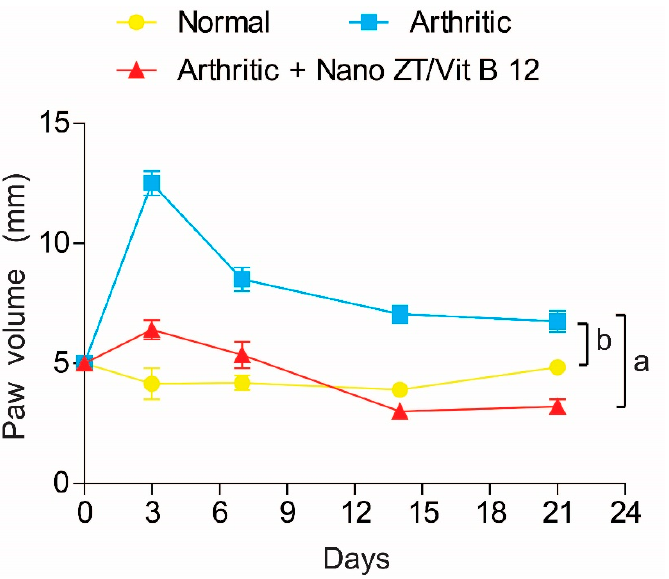
Figure 8. Effect of Nano ZT/Vit B 12 on right hind paw size in rats with CFA-induced arthritis. Means, which have different symbols, differ significantly at p < 0.05.